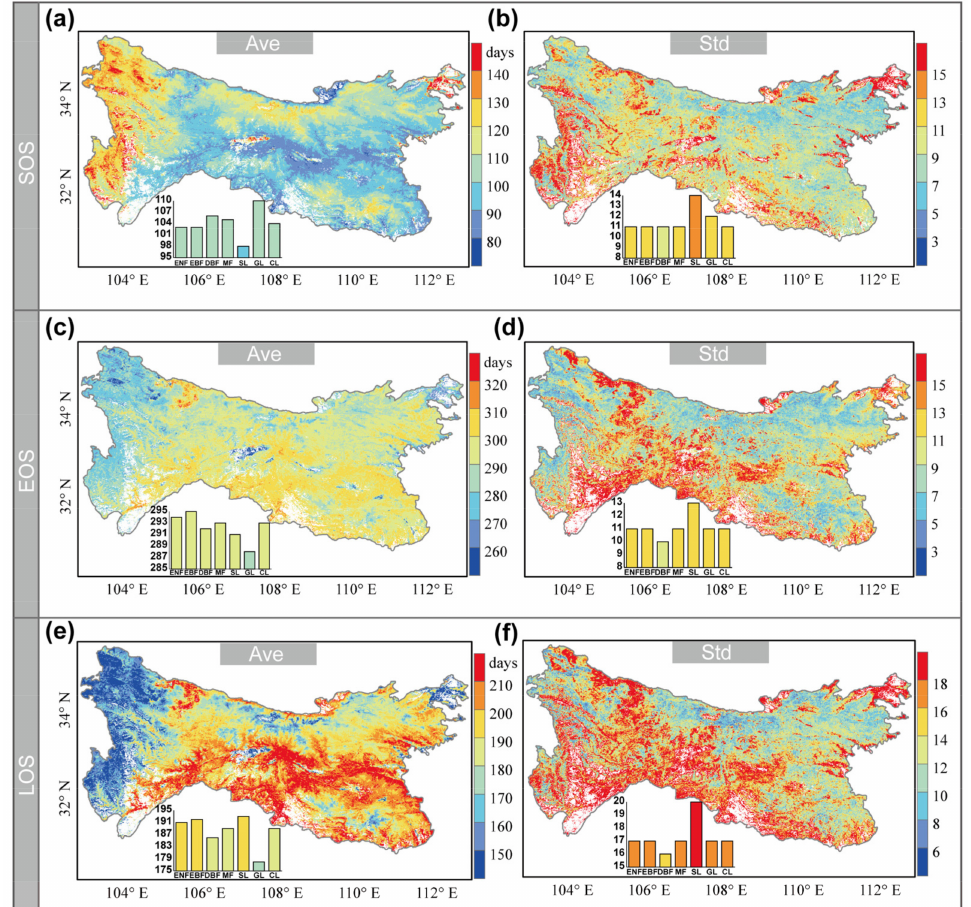
Figure 4. ( a , c , e ) Spatial distribution of the average phenology metrics from 2001 to 2019 and ( b , d , f ) standard deviation (Std) of the phenology metrics. Insets at bottom left show the histogram of the average pixel values for different vegetation